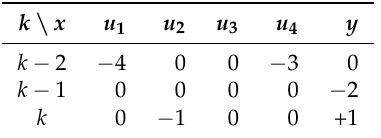
Table 1. Optimal-mask